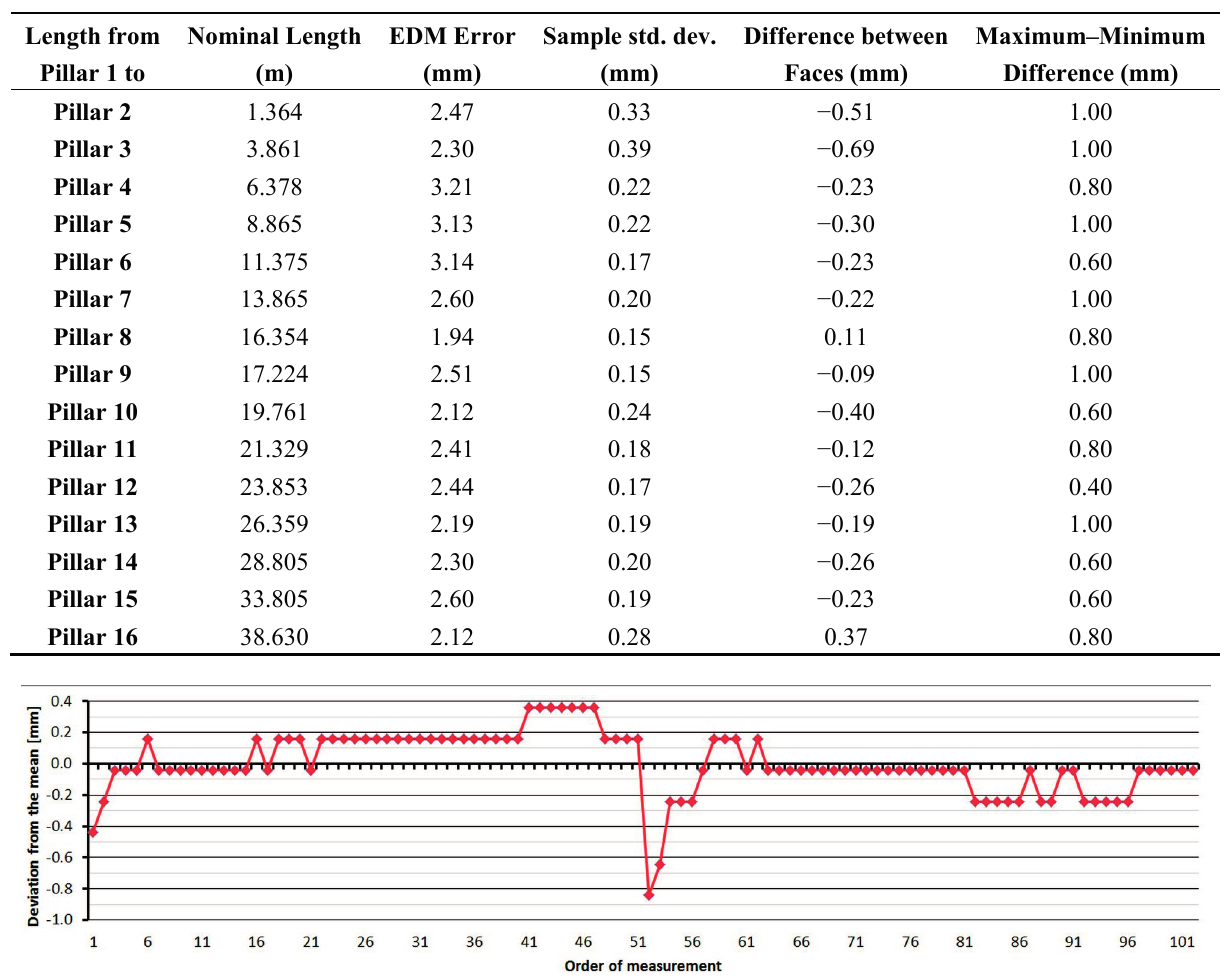
Figure 15. Topcon GPT-7501–Differences from average distance–pillar 7 (13.9